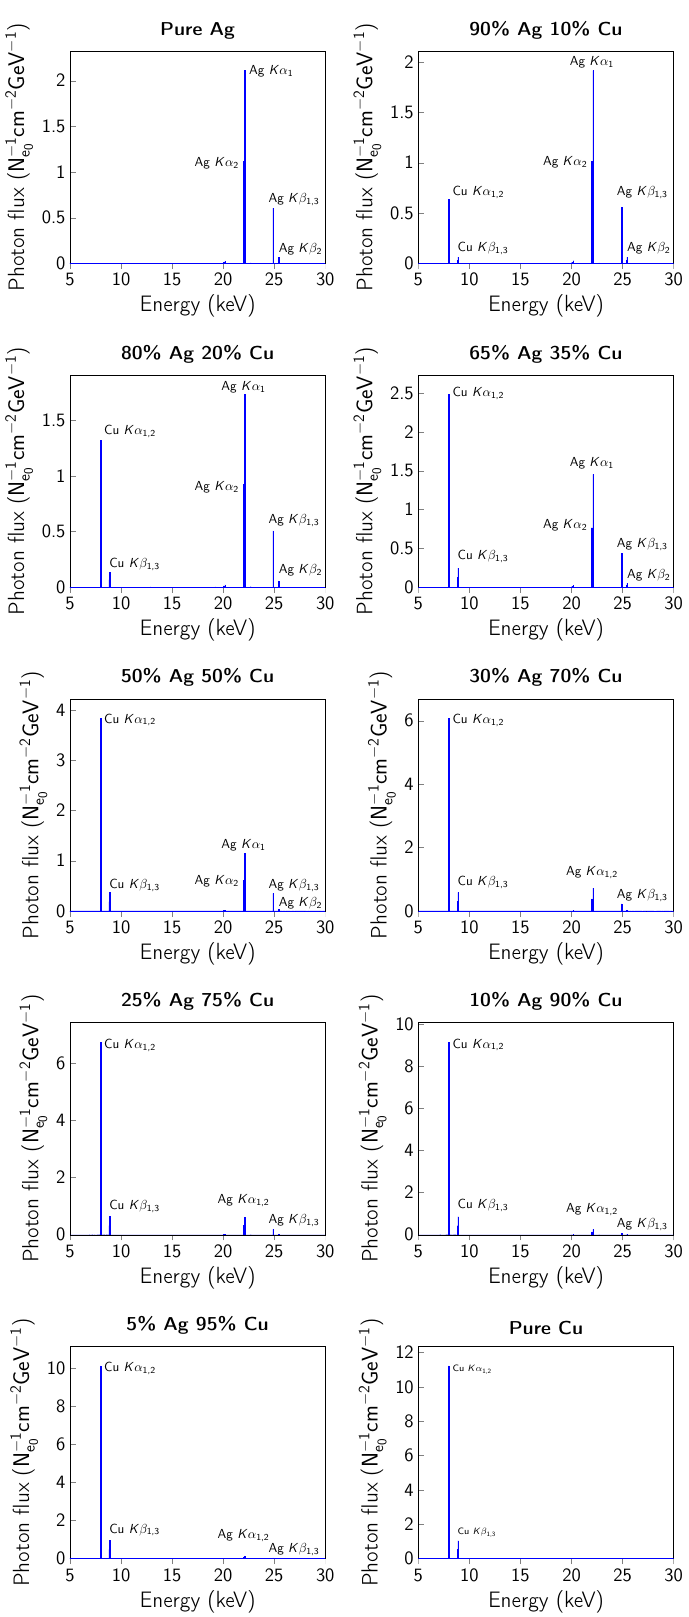
Figure 3. X-ray spectra in studied Ag–Cu